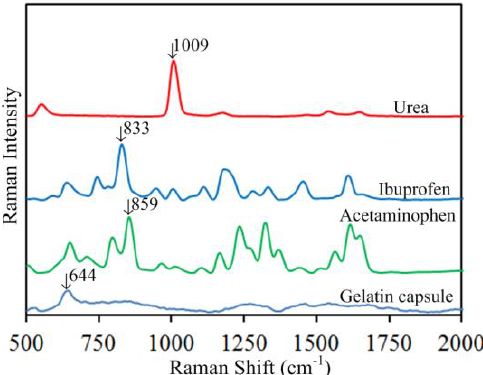
Figure 3. Reference Raman spectra of urea, ibuprofen, acetaminophen, and gelatin capsule.